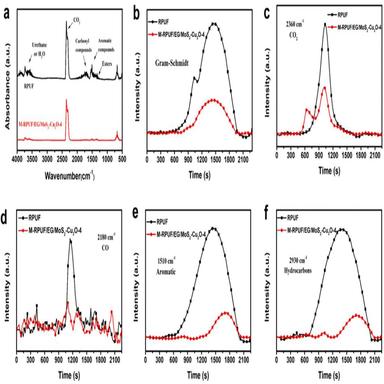
FT-IR spectrum of pyrolysis products for pristine RPUF and M-RPUF/EG/MoS2-Cu2O at the maximum decomposition rate (a), Gram-Schmidt curves (b) and intensity of characteristic peaks for pyrolysis products of pristine RPUF and M-RPUF/EG/MoS2-Cu2O-4 composite (c-f).